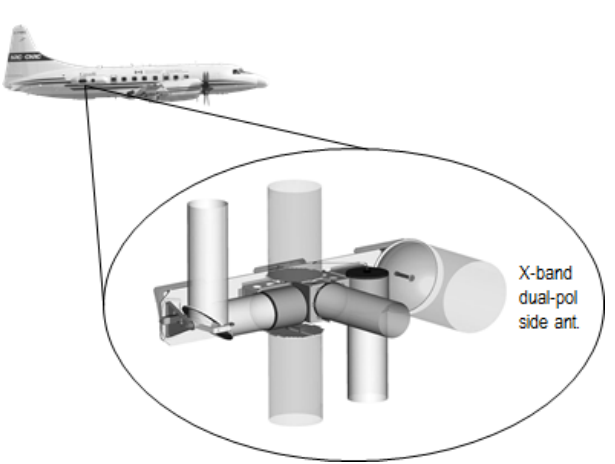
Figure 2. The NRC Convair CV-580 and the dual-polarization side- looking X-band radar. Table 1. X-band radar parameters for the Cayenne campaign.